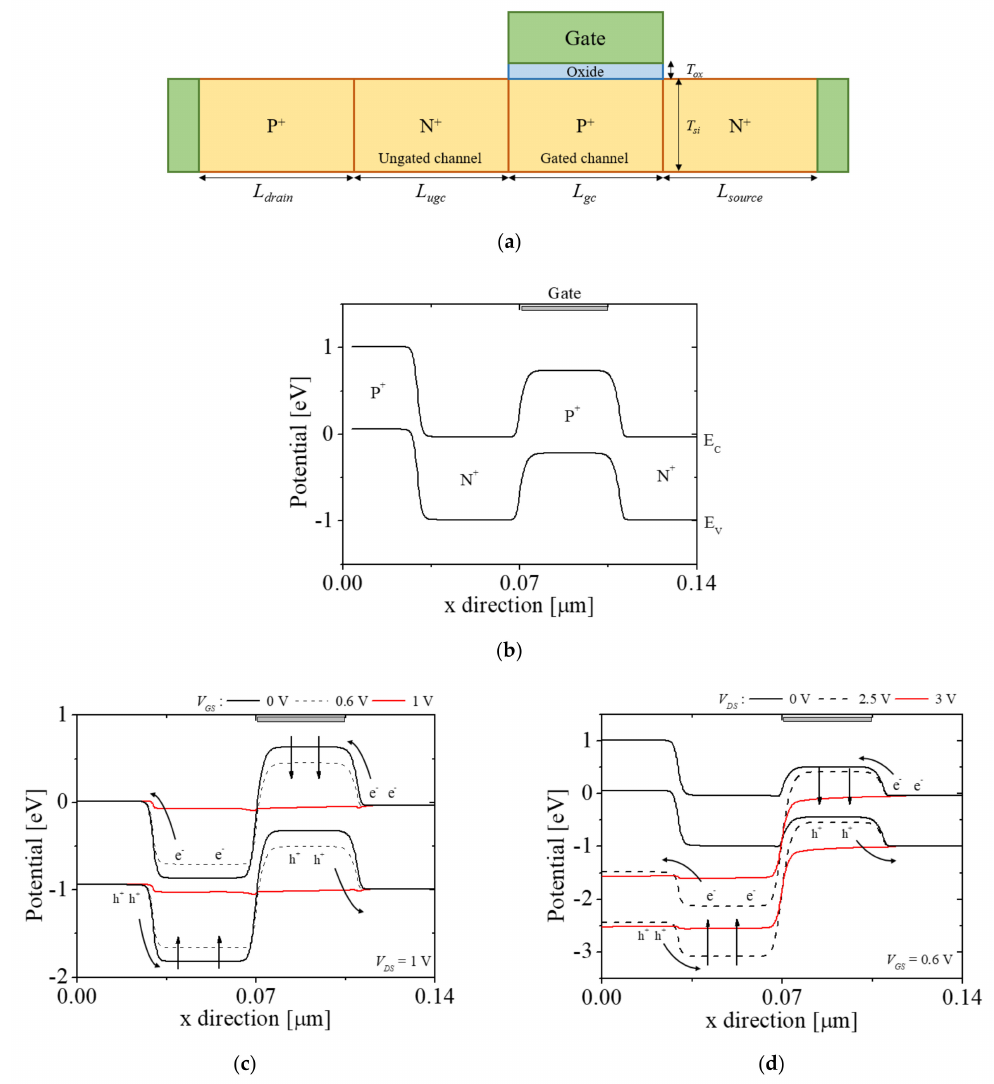
Figure 1. ( a ) Schematic diagram of an N–type feedback field–effect transistor (NFBFET). The energy band diagrams of the NFBFET; ( b ) at off state ( V DS = 0 V and V GS = 0 V); ( c ) at V DS = 1 V and different V GS ; and ( d ) at V GS = 0.6 V and different V DS